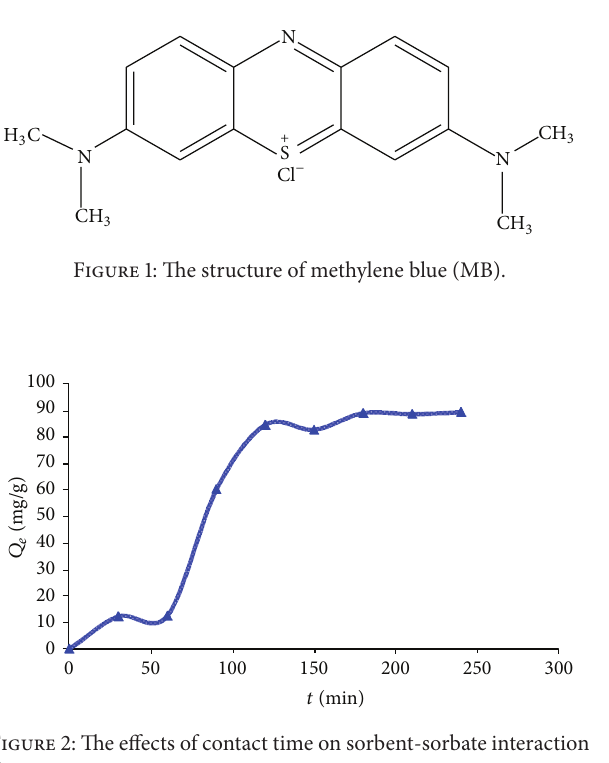
Figure 2: The effects of contact time on sorbent-sorbate interaction time.